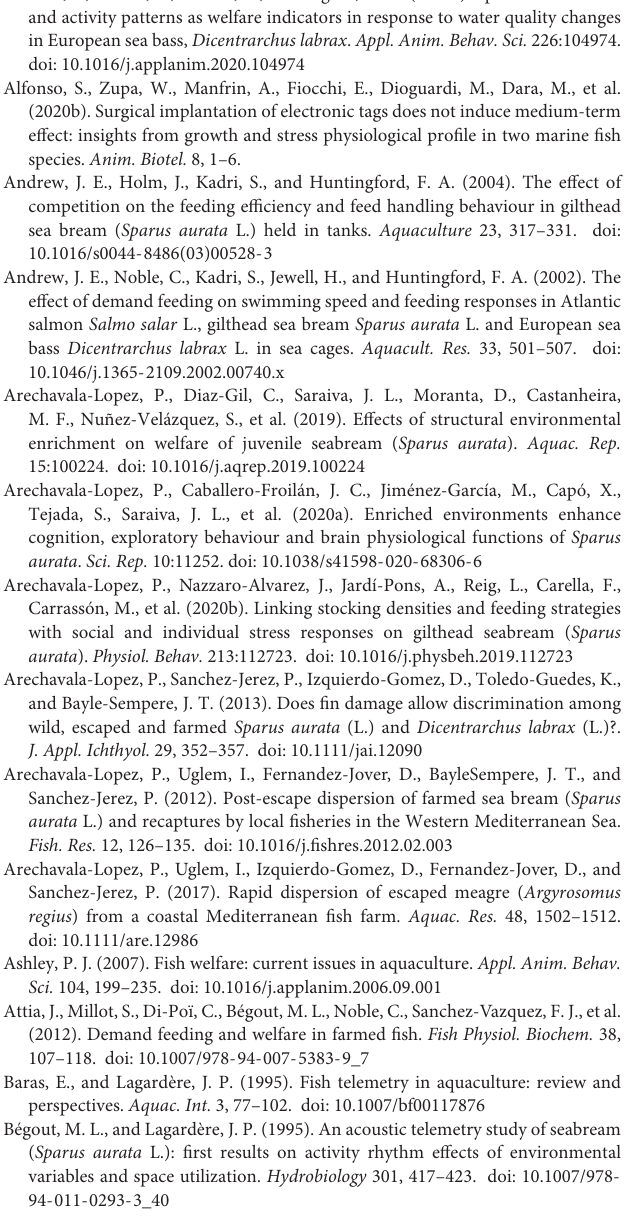
FIGURE S1 | Left: Schematic representation of the experimental cage, receivers and sync-tag location, and environmental enrichment used in this study (note that the image is not to scale). Right: Heatmap of error sensitivity for fish positioning estimated in the present study, which shows the mean deviation between the